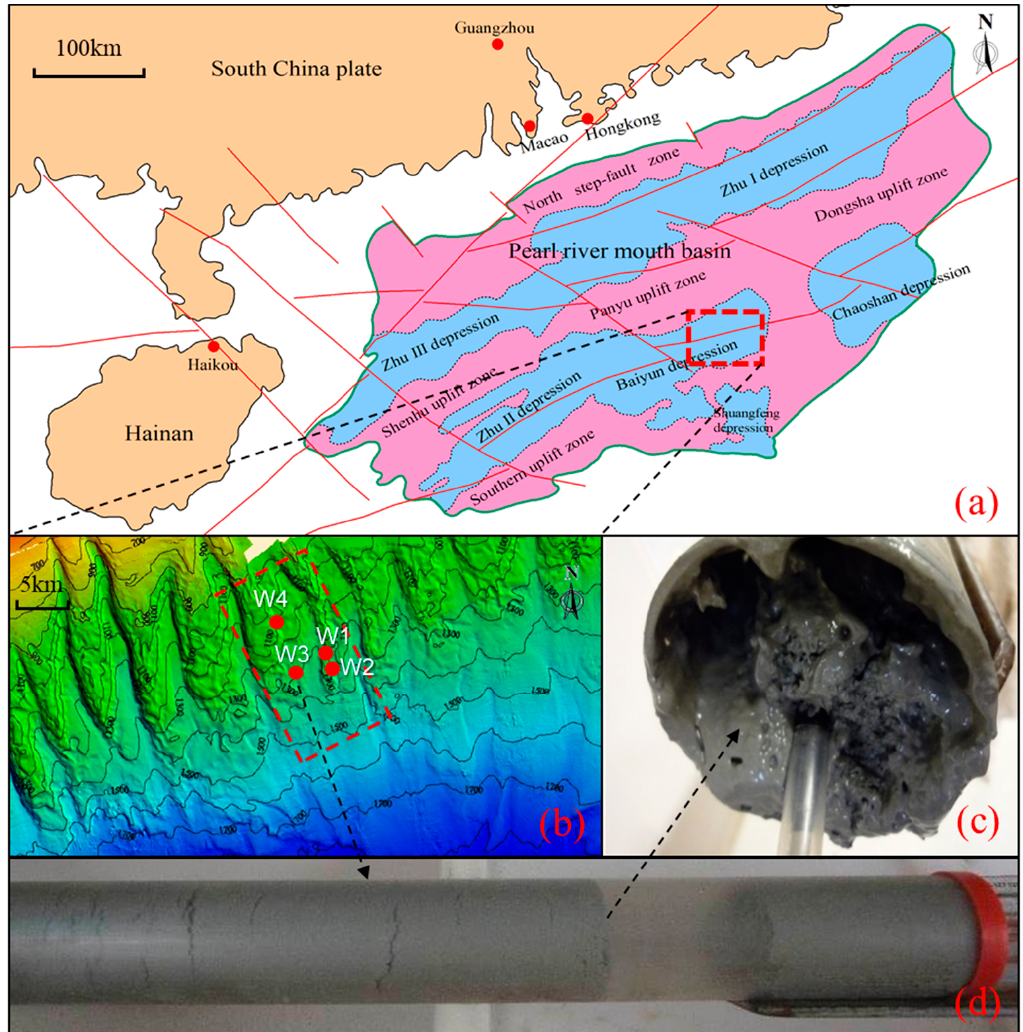
Figure 1. ( a ) Tectonic position of the Pearl River Mouth Basin. ( b ) Geomorphology and well position in the gas hydrate drilling cruises in study area (red rectangle). ( c ) Gas hydrate reservoirs in the unconsolidated fine-grained sediments ( d ) Unconsolidated fine-grained sediments.